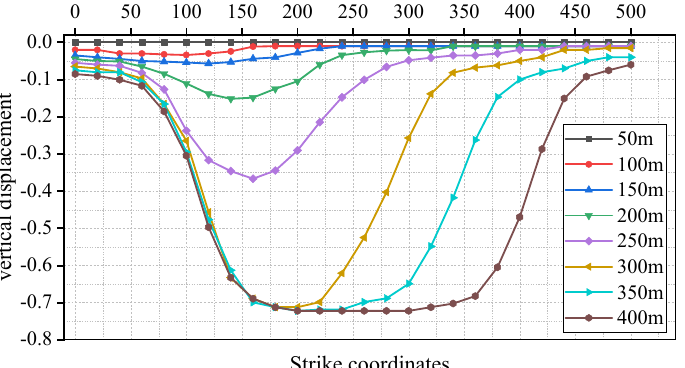
Figure 7. Surface vertical displacement for the karst aquifer with water.